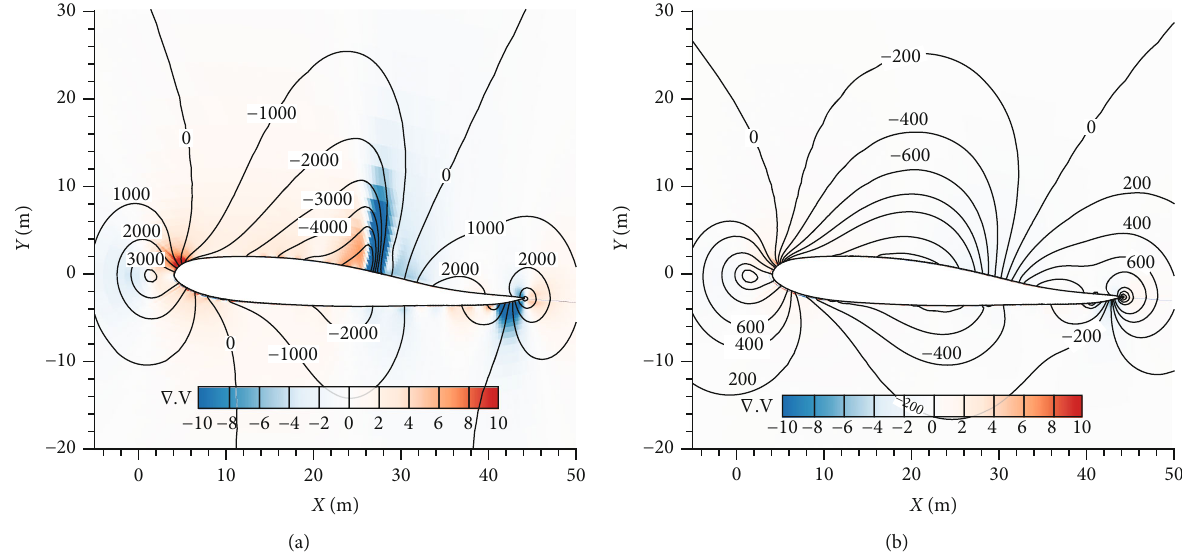
fl ood is for ∇⋅ V , and the contour line is for Figure 17: The contour of velocity divergence ∇⋅ V and relative pressure p − p ∞ . The contour p − p fi gures are the value of p − p : 85 . (b) The contours at Ma = 0 : 6 ∞ . The labeled ∞ . (a) The contours at Ma = 0